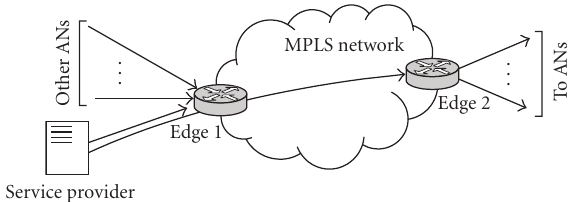
Figure 1: Reference configuration of the